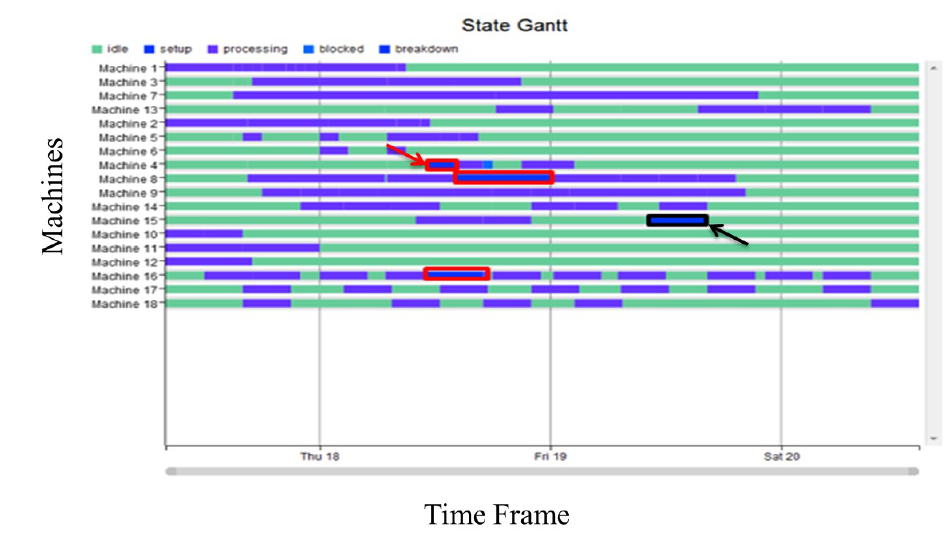
Figure 16. State chart for production schedule using EDD as a dispatching